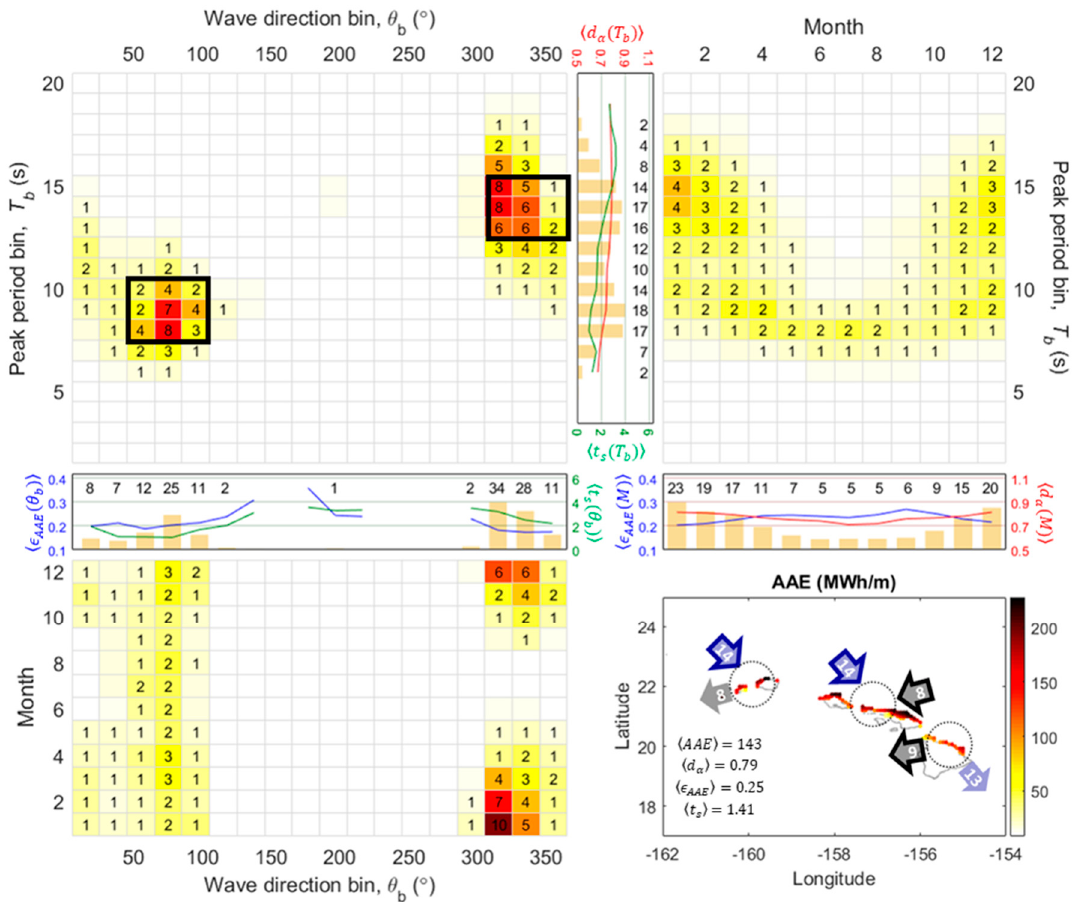
Figure 6. [Region 5: Hawaiian—Northern Coast] The detailed descriptions are identical to Figure 2. As relative contributions from the two dominant wave systems vary for each sub-region, thinner boxes (secondary dominant wave system) are blended with the bold boxes (most dominant wave systems) in the AAE ( T b , θ b ) .